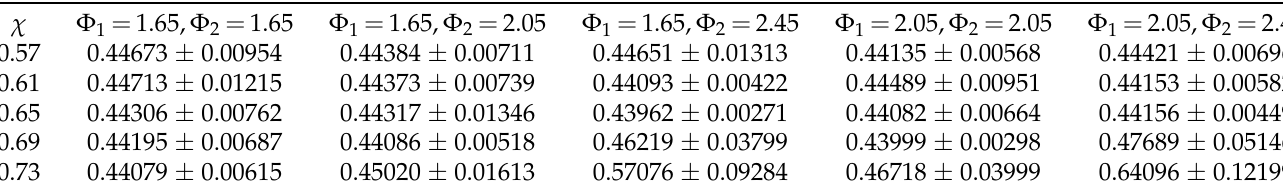
Table 1. The values of the arithmetic mean and standard deviation of f 1 obtained using PSO with I = 100, D = 80, (cid:96) = 12, n = 25 for 50 calculations with the metric d 1 . χ Φ 1 = 1.65, Φ 2 =